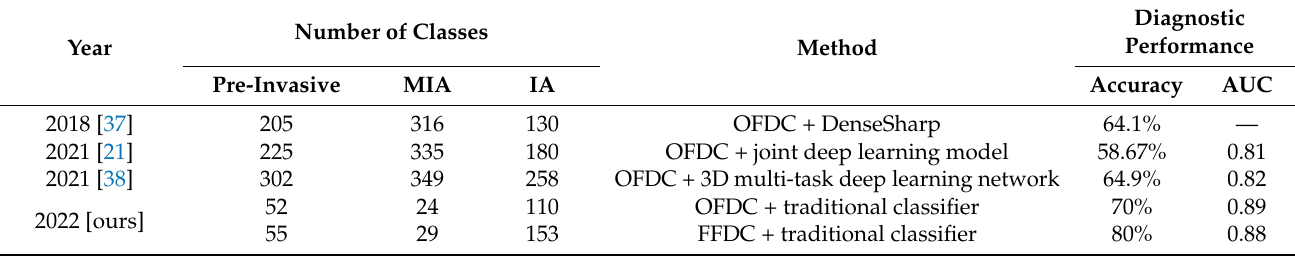
Table 5. Comparison of studies using different methods to determine the